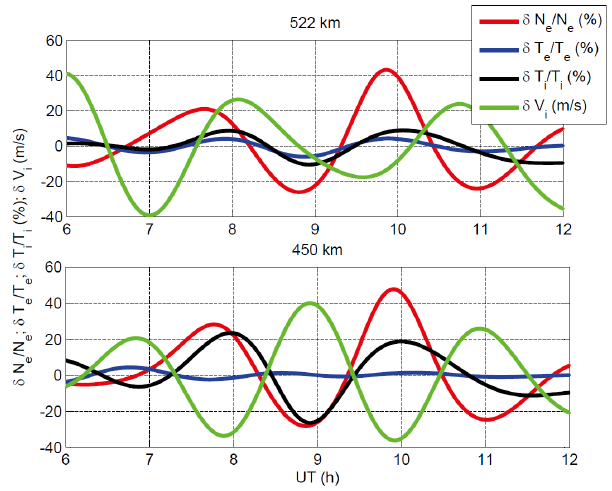
Fig. 3. Time series of the TID quantities ( δN e /N 0 e ,δT e /T 0 e , Figure 3. Time series of the TID quantities ( VTTTTNN  ,/,/,/ 000 ) from the iiieeee δT i /T 0 ,δV i ) from the fixed field-aligned 42m dish. The top panel i fixed field-aligned 42m dish. The top panel is for 522 km and bottom panel for 450 is for 522km and bottom panel for km.